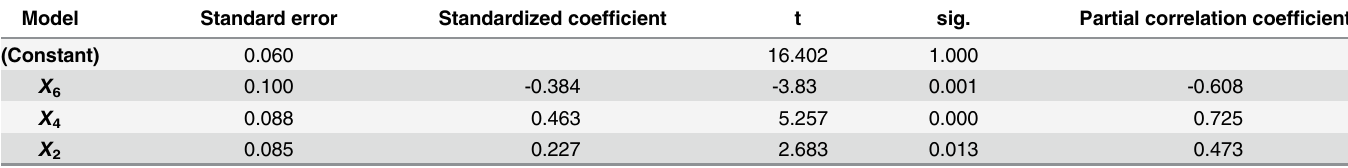
Table 6. Multivariate stepwise regression coefficient of soil erosion driving factors in the ecological restoration area.